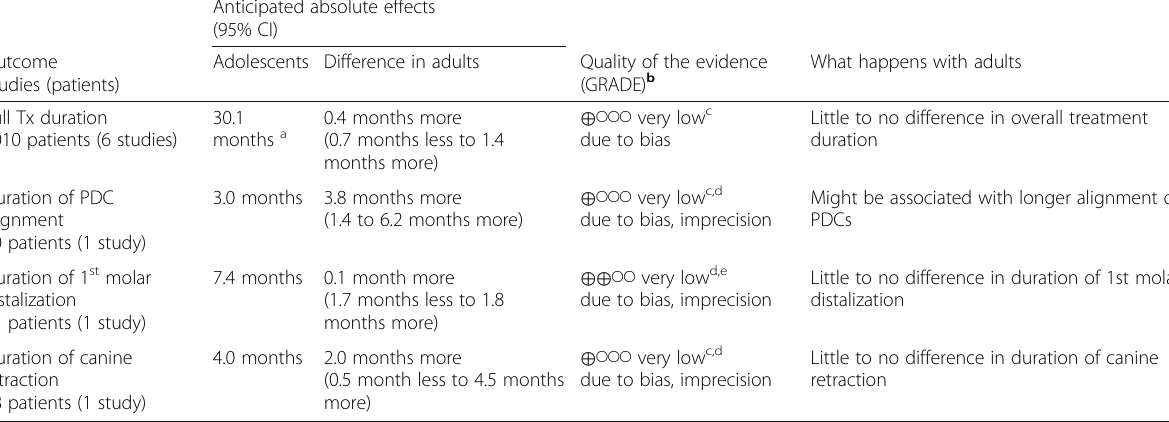
Table 4 Summary of findings table according to the GRADE